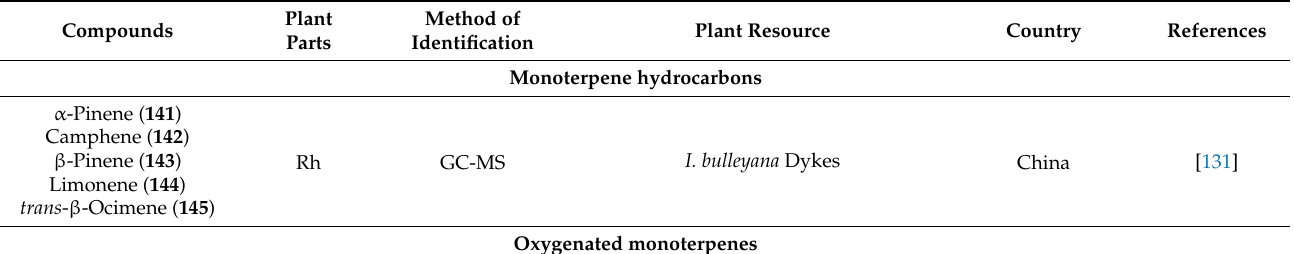
Table 5. Genus Iris essential oil chemical